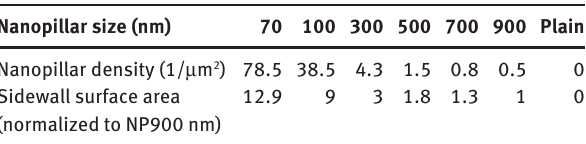
Table 2: Nanopillar density and sidewall surface area of different MQW